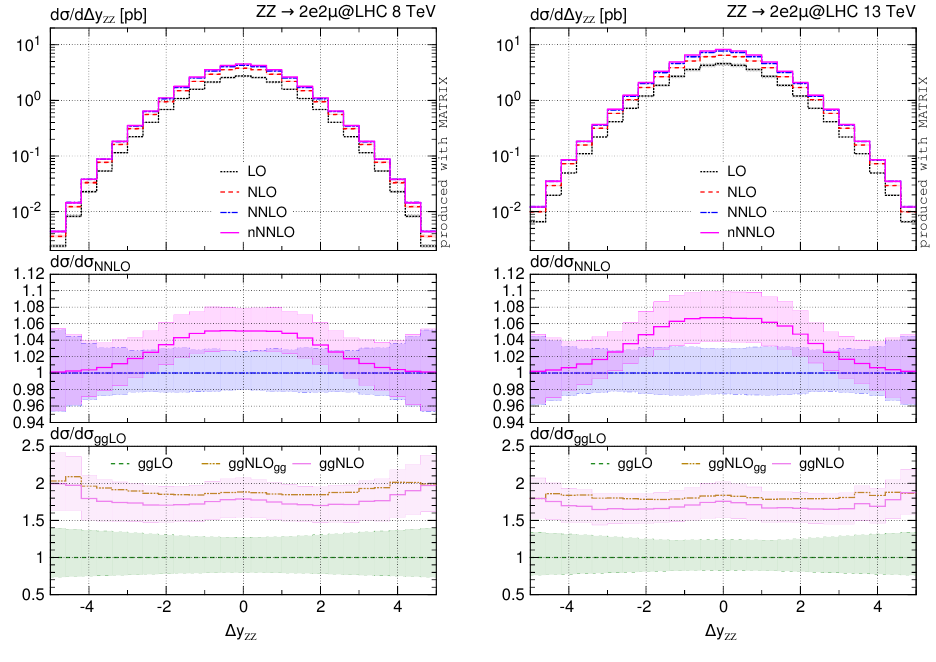
Figure 6 . Di(cid:11)erential distribution in (cid:1) y ZZ at 8 TeV (left) and 13 TeV (right).